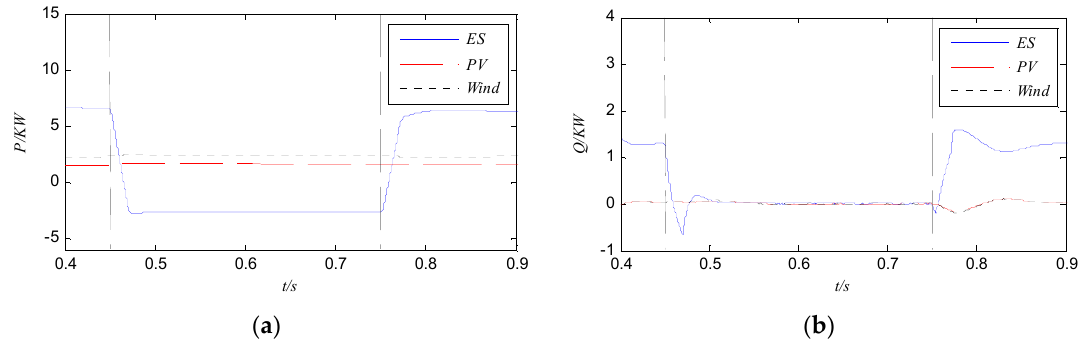
Figure 22. Active and reactive power output curves of micro ‐ source. ( a ) Active power output; ( b ) Reactive power output.